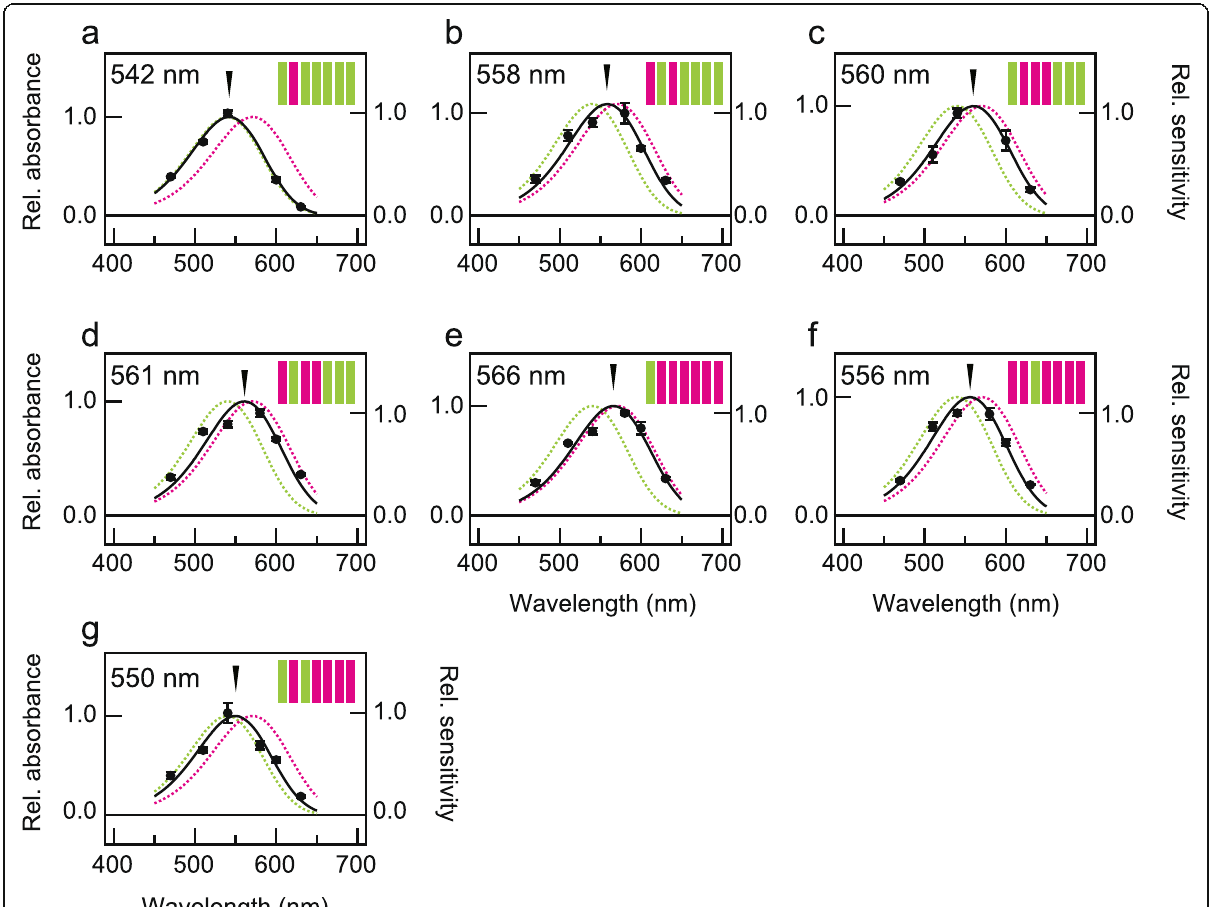
Fig. 4 Evaluation of the involvement of helix3 of PxRh3 in the red-shift. The absorption spectra of chimeric mutants with respect to the transmembrane helix between PxRh1_Gs and PxRh3_Gs, Rh3(II)/Rh1(I,III-VII) ( a ), Rh3(I,III)/Rh1(II,IV-VII) ( b ), Rh3(II-IV)/Rh1(I,V-VII) ( c ), Rh3(I,III,IV)/Rh1(II,V- VII) ( d ), Rh1(I)/Rh3(II-VII) ( e ), Rh1(III)/Rh3(I,II,IV-VII) ( f ), Rh1(I,III)/Rh3(II,IV-VII) ( g ) were estimated by heterologous action spectroscopy. Solid circles represent the mean relative sensitivities of cultured cells expressing each chimeric mutant at each wavelength of light irradiation ( n = 3) and black curves indicate estimated absorption spectra. The error bar shows standard error. The absorption spectra of PxRh1_Gs and PxRh3_Gs are also indicated by green and magenta broken curves, respectively. Schematic drawings of seven transmembrane structures of butterfly opsins are also shown, in which helices of PxRh1 and PxRh3 are indicated by green and magenta,